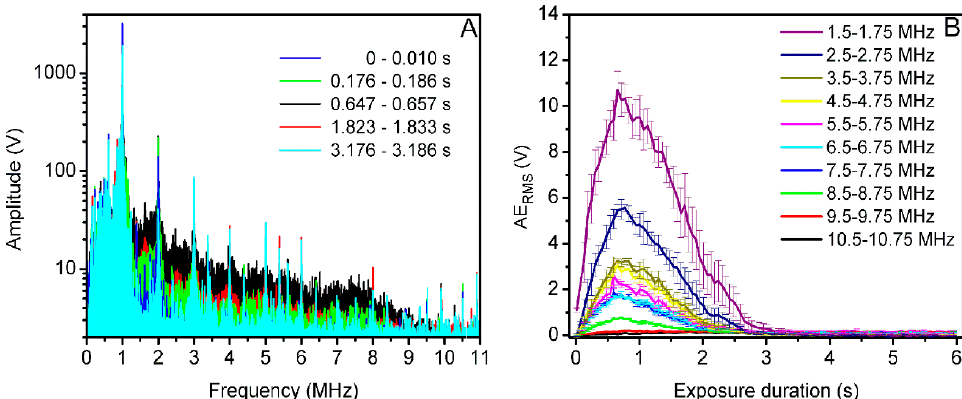
Figure 8. Broadband noise temporal evolution in frequency spectrum ( A ), AE RMS dynamics of the corresponding signal, evaluated in different frequency ranges ( B ), at 400 kPa acoustic pressure US.